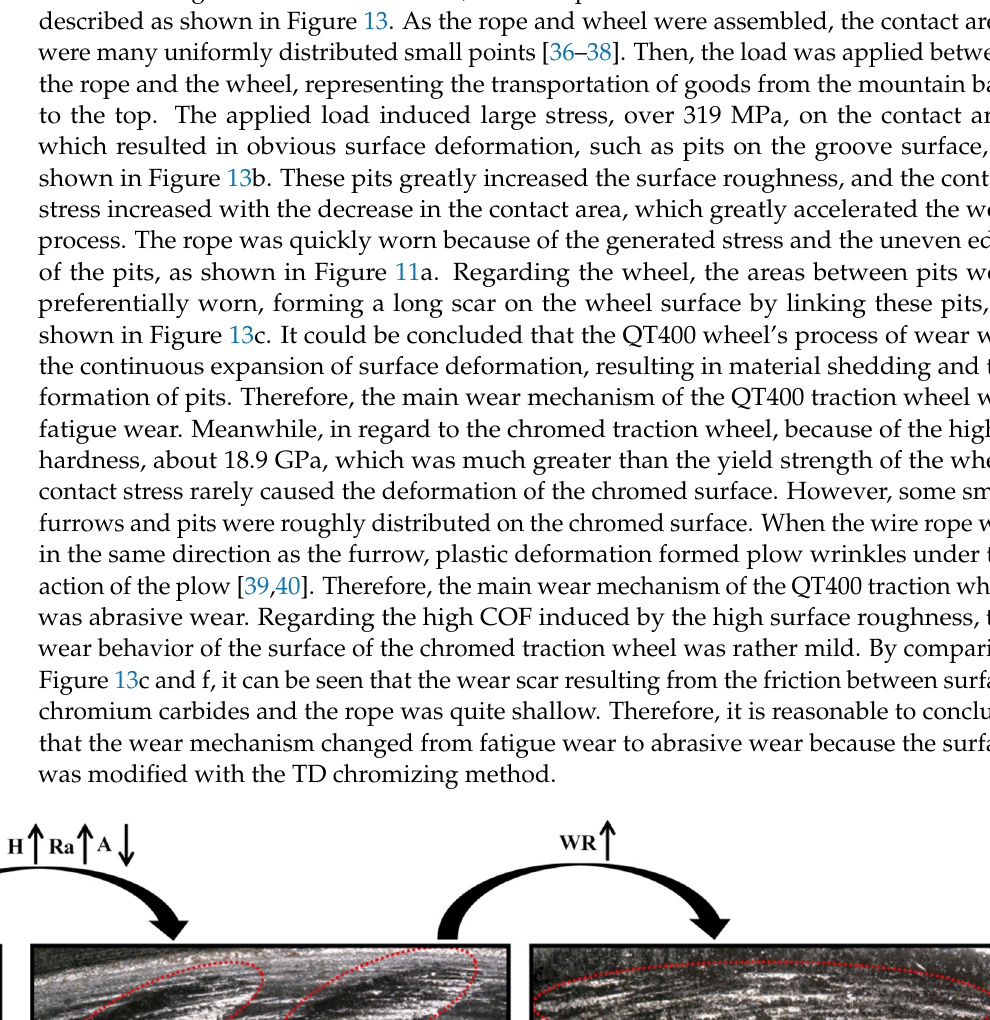
Table 2. Material parameters of the traction wheel and wire rope.